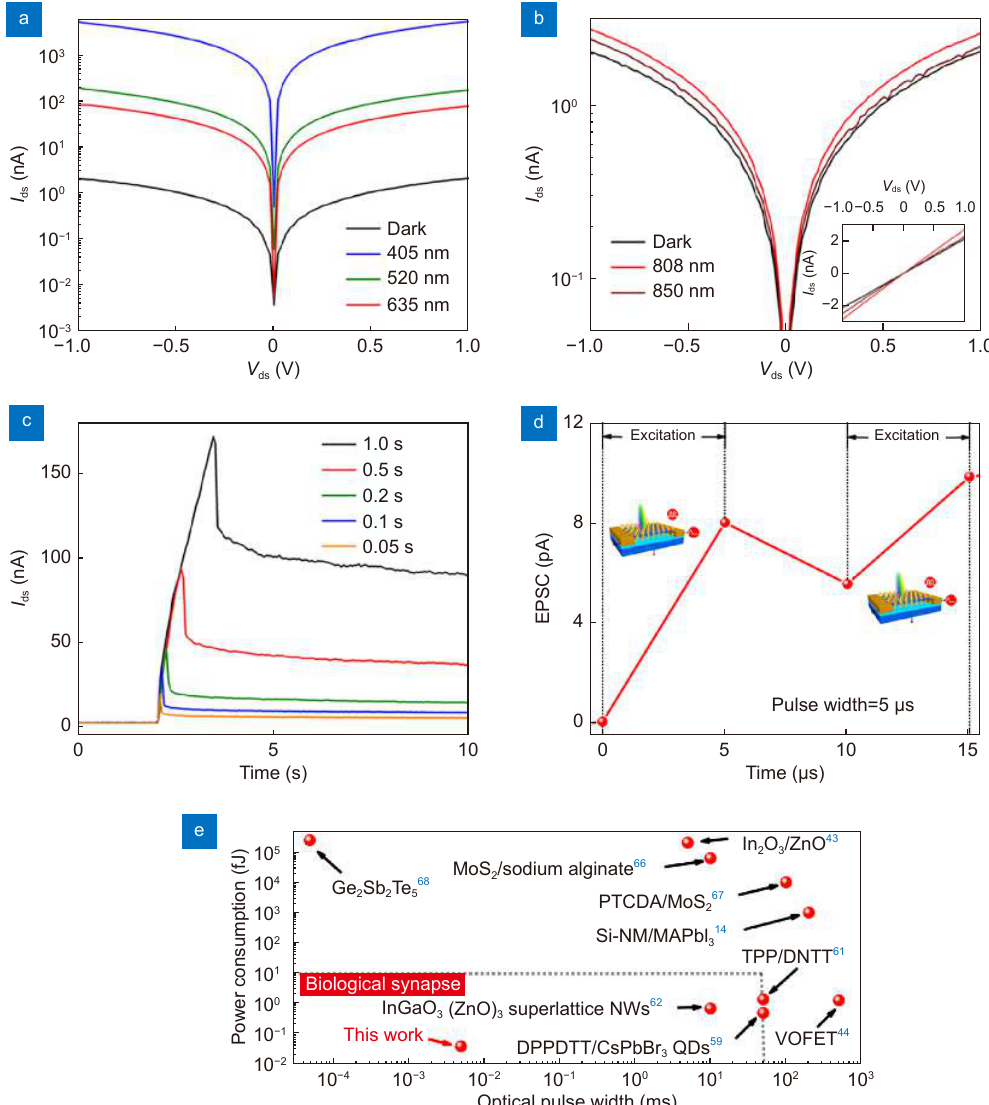
Fig. 2 | Photodetection and spike-duration plasticity of the MoS 2 synaptic transistor. Output characteristic curves of the MoS 2 synaptic transistor in visible light ( a ) and NIR light ( b ). The inset in (b) is the corresponding linear output characteristic curve. ( c ) The transient current re- sponses triggered by several optical stimulus with different duration of a single pulse, respectively. ( d ) The EPSC at the pulse width of 5 μs (405 nm, V ds = 1 V). ( e ) Comparison of single optical pulse width and power consumption among some synaptic